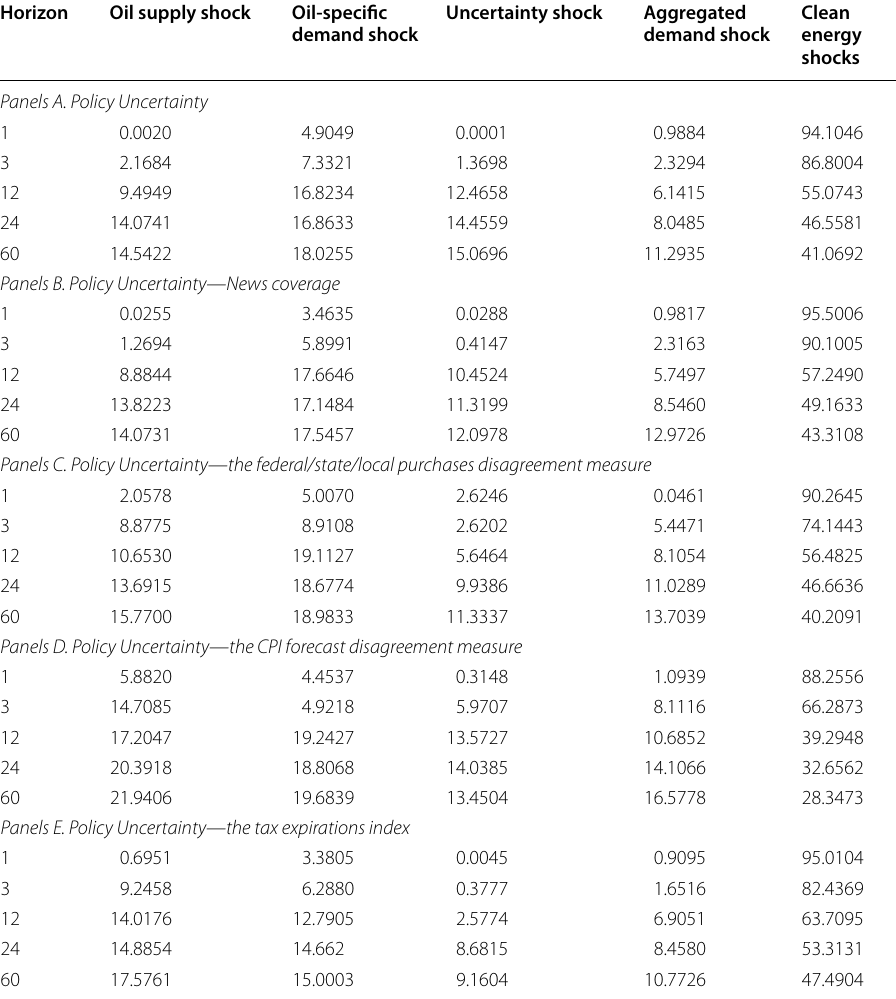
Uncertainty shock Aggregated Clean demand shock demand shock energy shocks